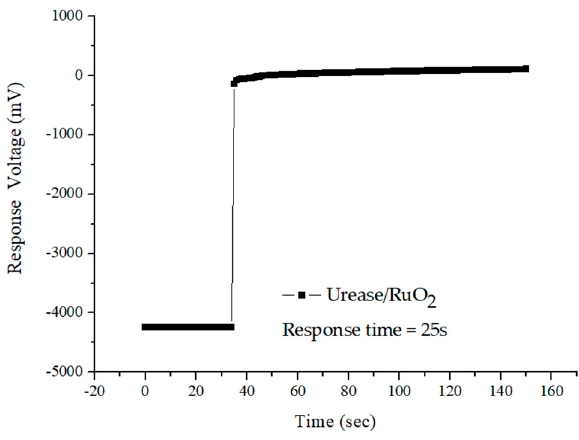
Figure 7. The response time of the flexible arrayed RuO 2 urea biosensor.